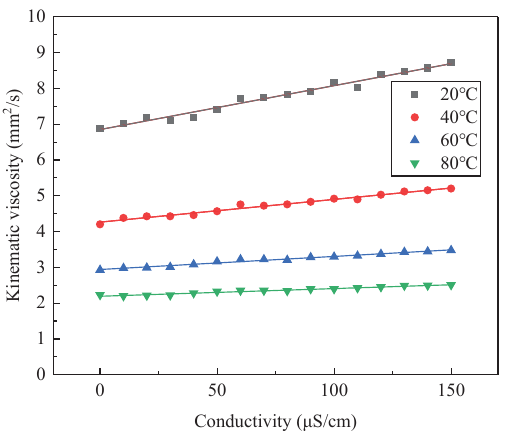
Figure 5: The linear fitting results of kinematic viscosity and conductivity of Jatropha curcas biodiesel.